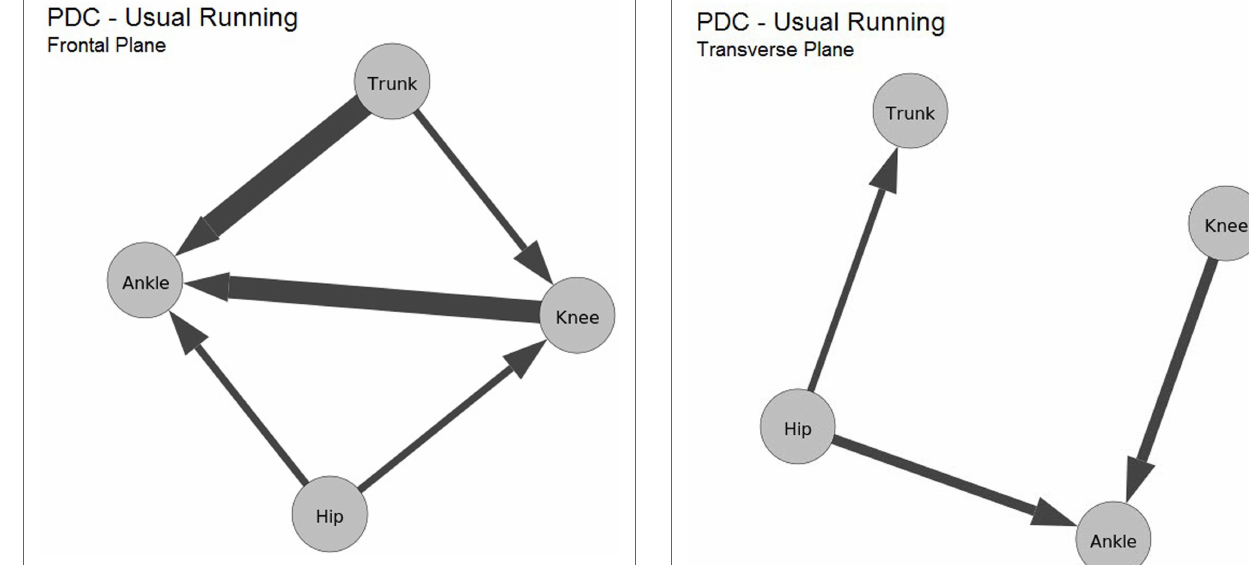
FIGURE 7 | Average values computed from maximum PDC values of the transverse plane kinematic data during running. Also, nodes are the kinematic Influence test